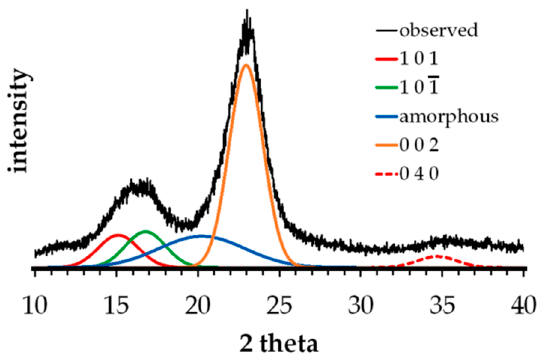
Figure 3. X-ray diffraction (XRD) peak deconvolution method to measure crystallinity index.